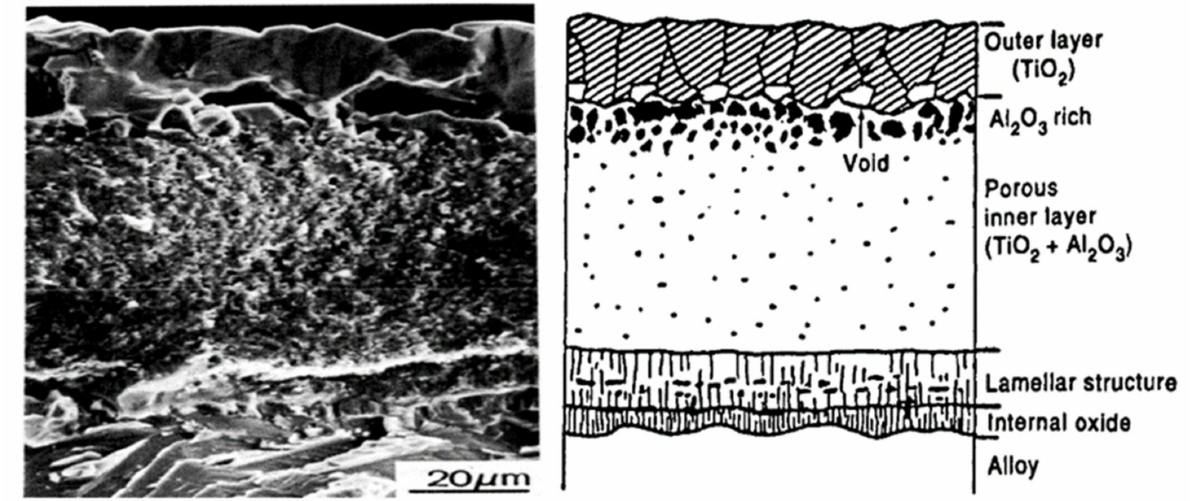
Figure 3. SEM micrograph of TiAl specimen oxidised at 1300 K for 100 ks in oxygen, showing several large voids near the interface between the TiO 2 outer layer and the TiO 2 + Al 2 O 3 interlayer. Reprinted from Intermetallics, 4, Shigeji Taniguchi, Toshio Shibata, Influence of additional elements on the oxidation behaviour of TiAl, S85–S93, Copyright (1996), with permission from Elsevier